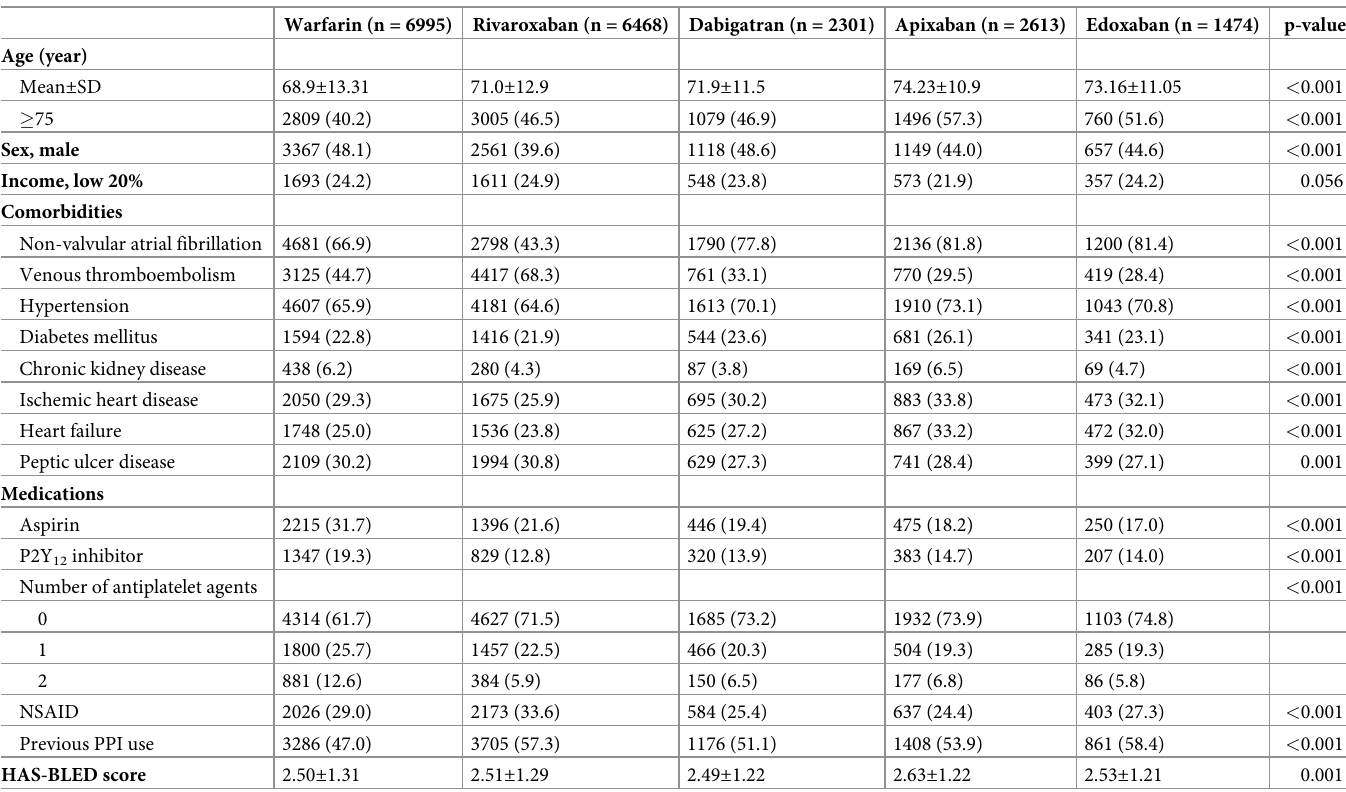
Table 1. Baseline characteristics of the study